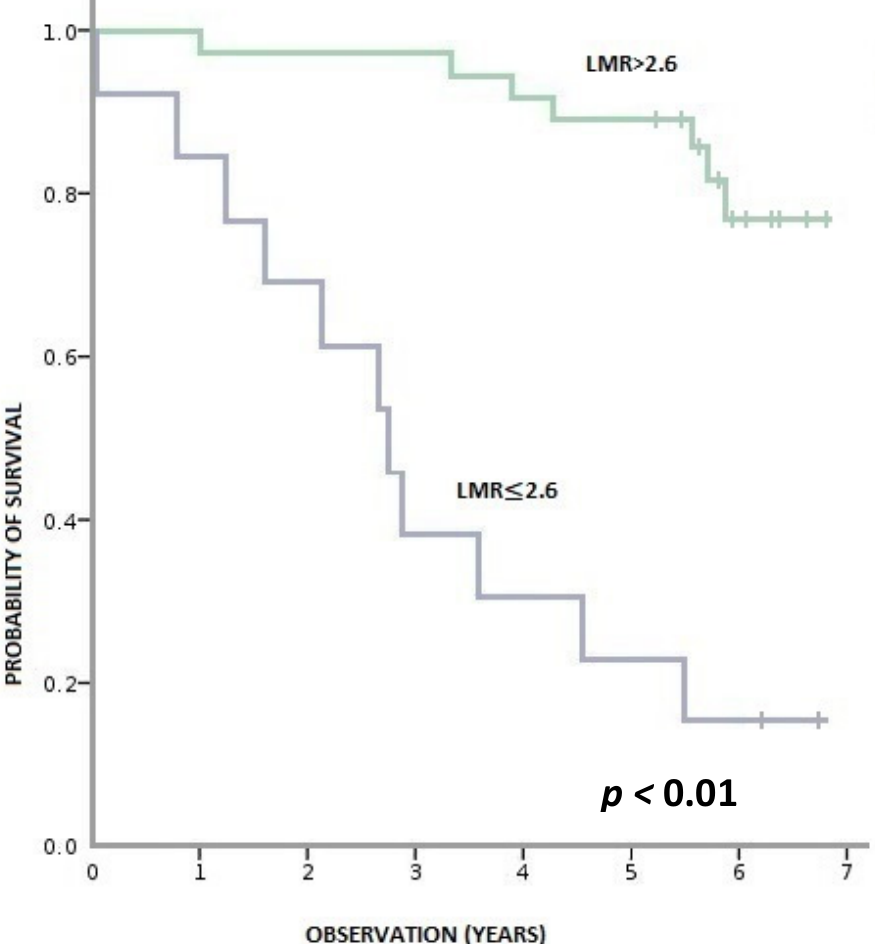
Figure 3. Overall survival according to pre-treatment LMR (lymphocyte-to-monocyte